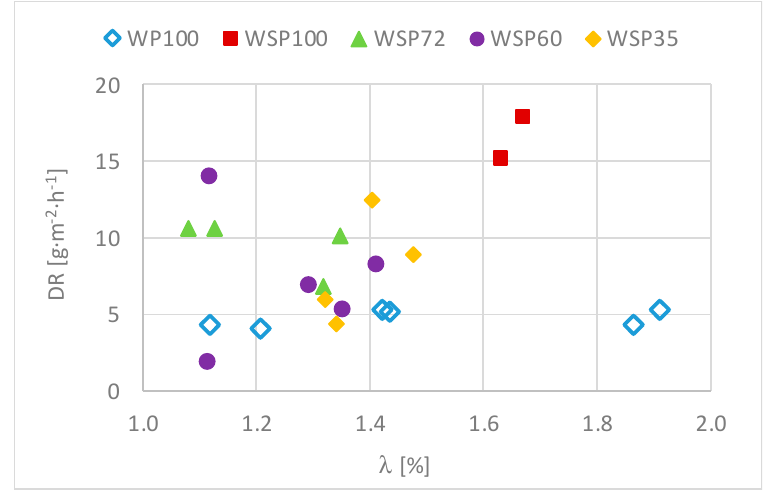
Figure 15. Deposition rate (DR) versus λ for the WP100 and WSP family.